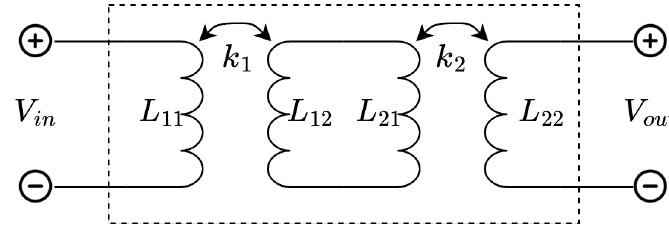
Figure 3. Circuit used for two-port modeling of the double